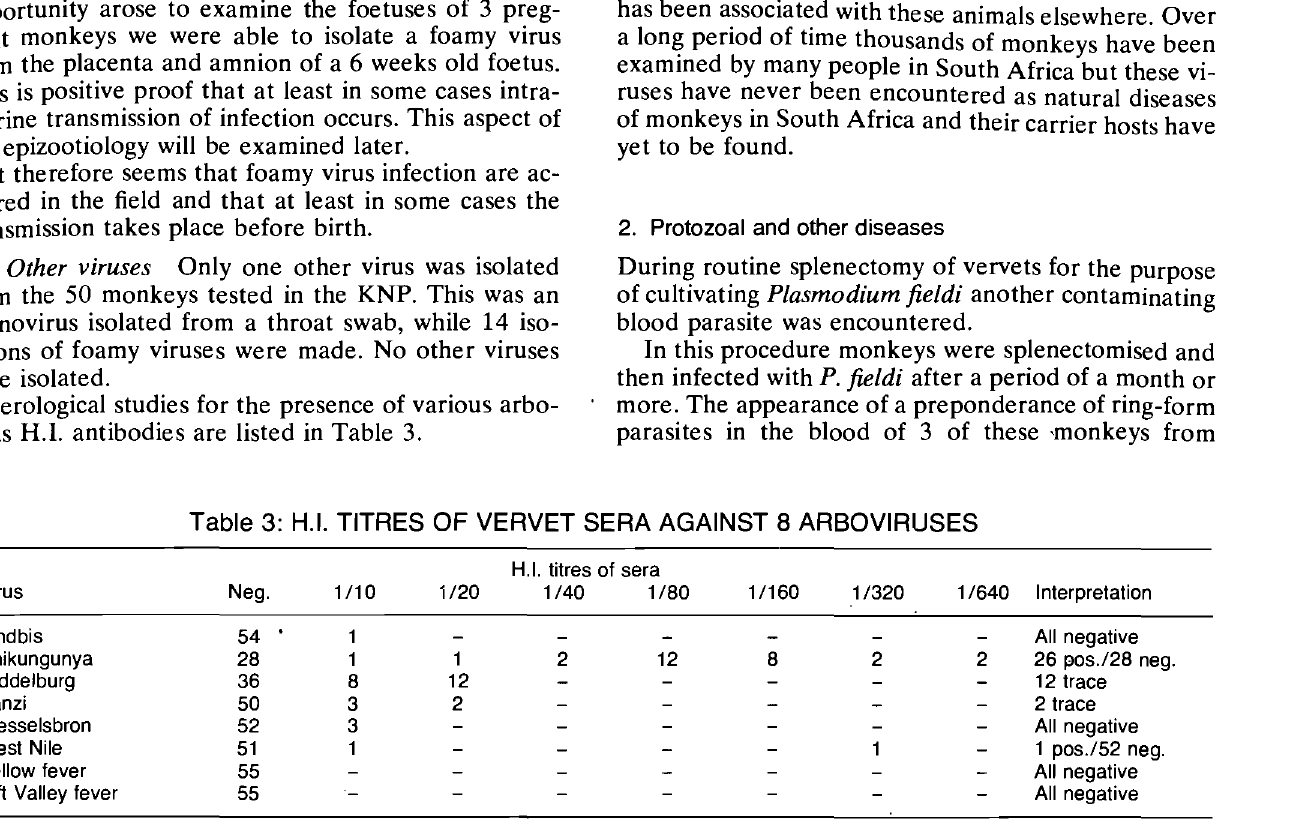
Table 3: H.1. TITRES OF VERVET SERA AGAINST 8